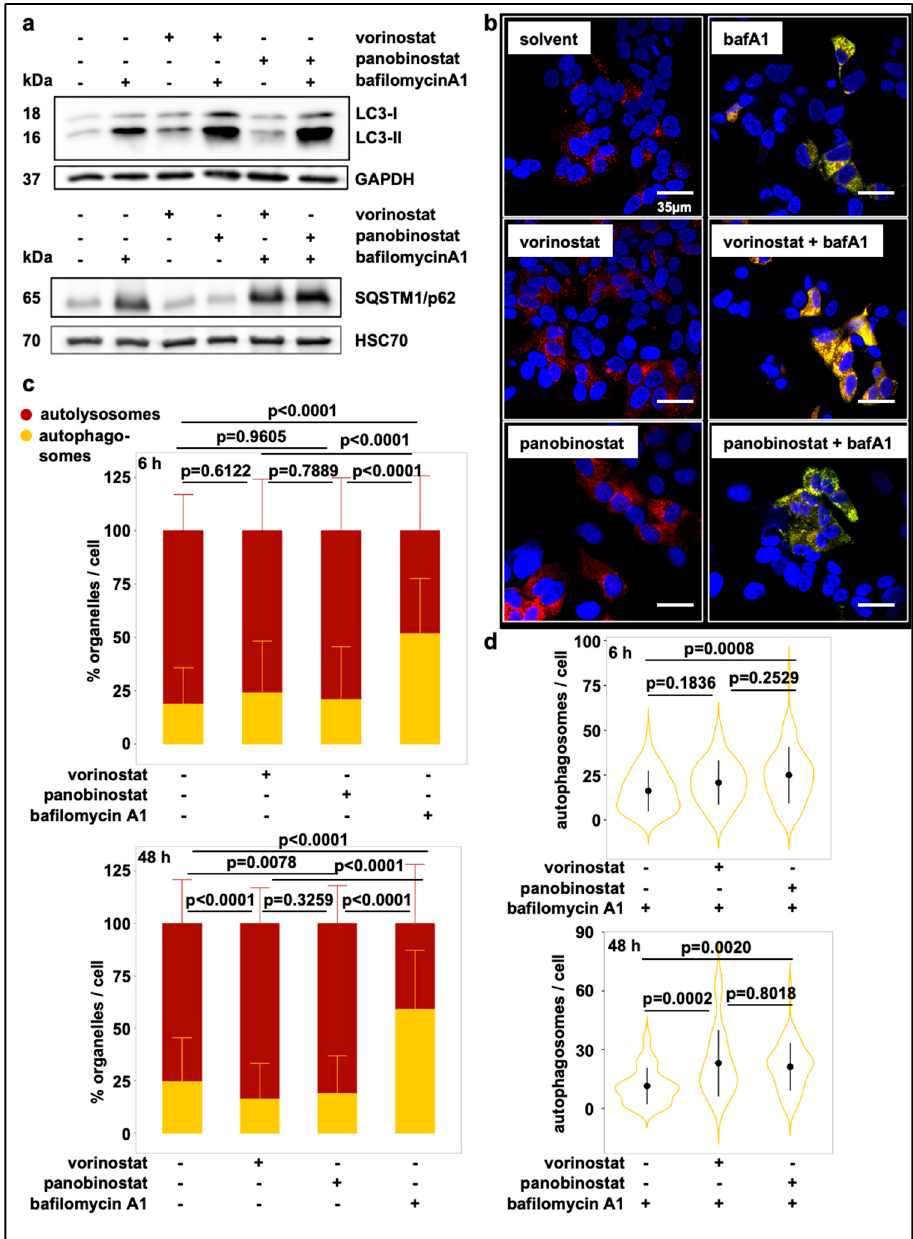
Figure 1. Treatment with broad-spectrum HDAC inhibitors induces autophagic flux. ( a ) Western Blot displaying LC3-I and LC3-II levels and SQSTM1/p62 levels in whole-cell lysates of SK-N-BE(2)-C cells after 24 h treatment with 500 nM vorinostat or 10 nM panobinostat or solvent control and with or without additional 6h treatment with bafilomycin A1 (100 nM). GAPDH and HSC70 served as a loading control for corresponding Western blots. ( b ) Confocal fluorescence microscopy analysis of SK-N-BE(2)-C cells. Autophagosome formation was visualized after treatment with vorinostat (500 nM) or panobinostat (10 nM) alone or in combination with 100 nM bafilomycin A1 by using the mCherry-EGFP-LC3B expression construct. Autolysosomes appear red fluorescent only, autophagosomes are red and green fluorescent (yellow in merged channels). Scale bar: 35 µm. ( c ) Automated quantification of one representative fluorescence microscopic experiments using the mCherry-EGFP-LC3B expression construct 6 h and 48 h after treatment with either HDACi or bafilomycin A1. Each transfected cell was analyzed for green and red fluorescent foci. Statistical analyses: ANOVA with Tukey’s multiple comparison test. ( d ) Automated quantification and statistical analyses for the combination treatment with bafilomycin A1 as described in ( c ).